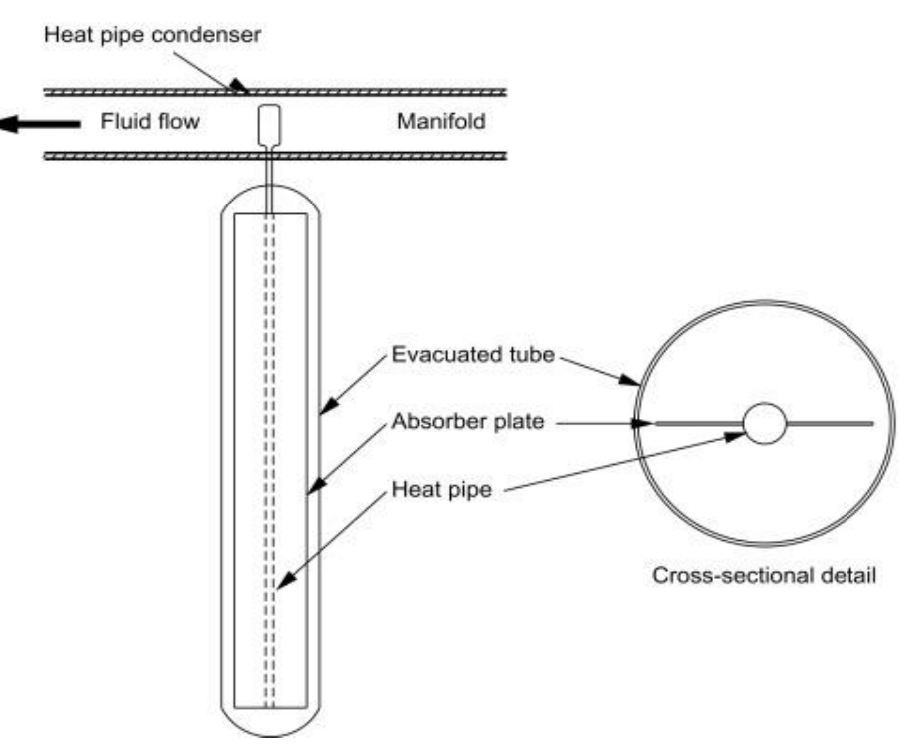
Figure 6. Evacuated tube collector [47].